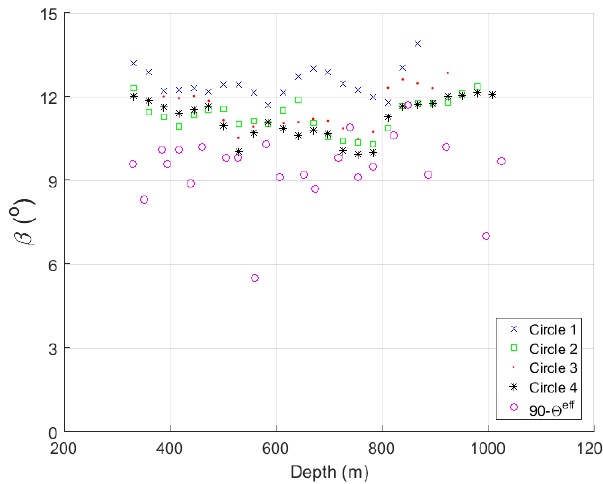
Figure 10. Comparison between the average angles of optic axis estimated from multi-polarization measurements and the effective c axis angles estimated from ice core data at different